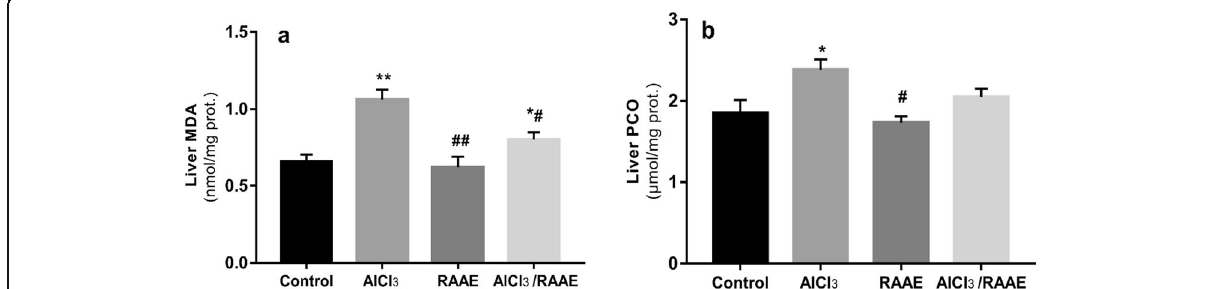
Fig. 1 Hepatic malondialdehyde (MDA) and carbonyl protein (PCO) levels in control and experimental groups. Data are expressed as mean ± SEM (n = 6 rats/group). AlCl